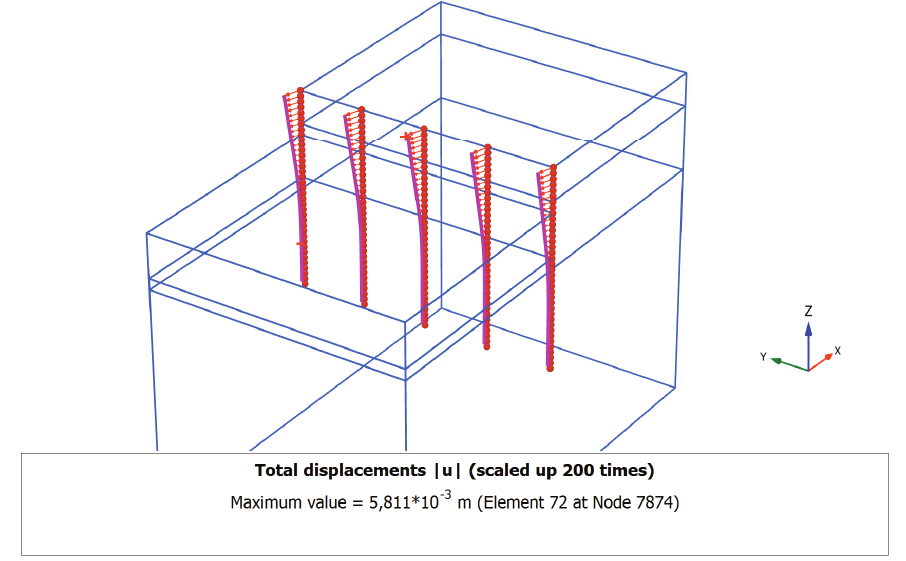
Fig. 11. Pile displacements after the completion of the